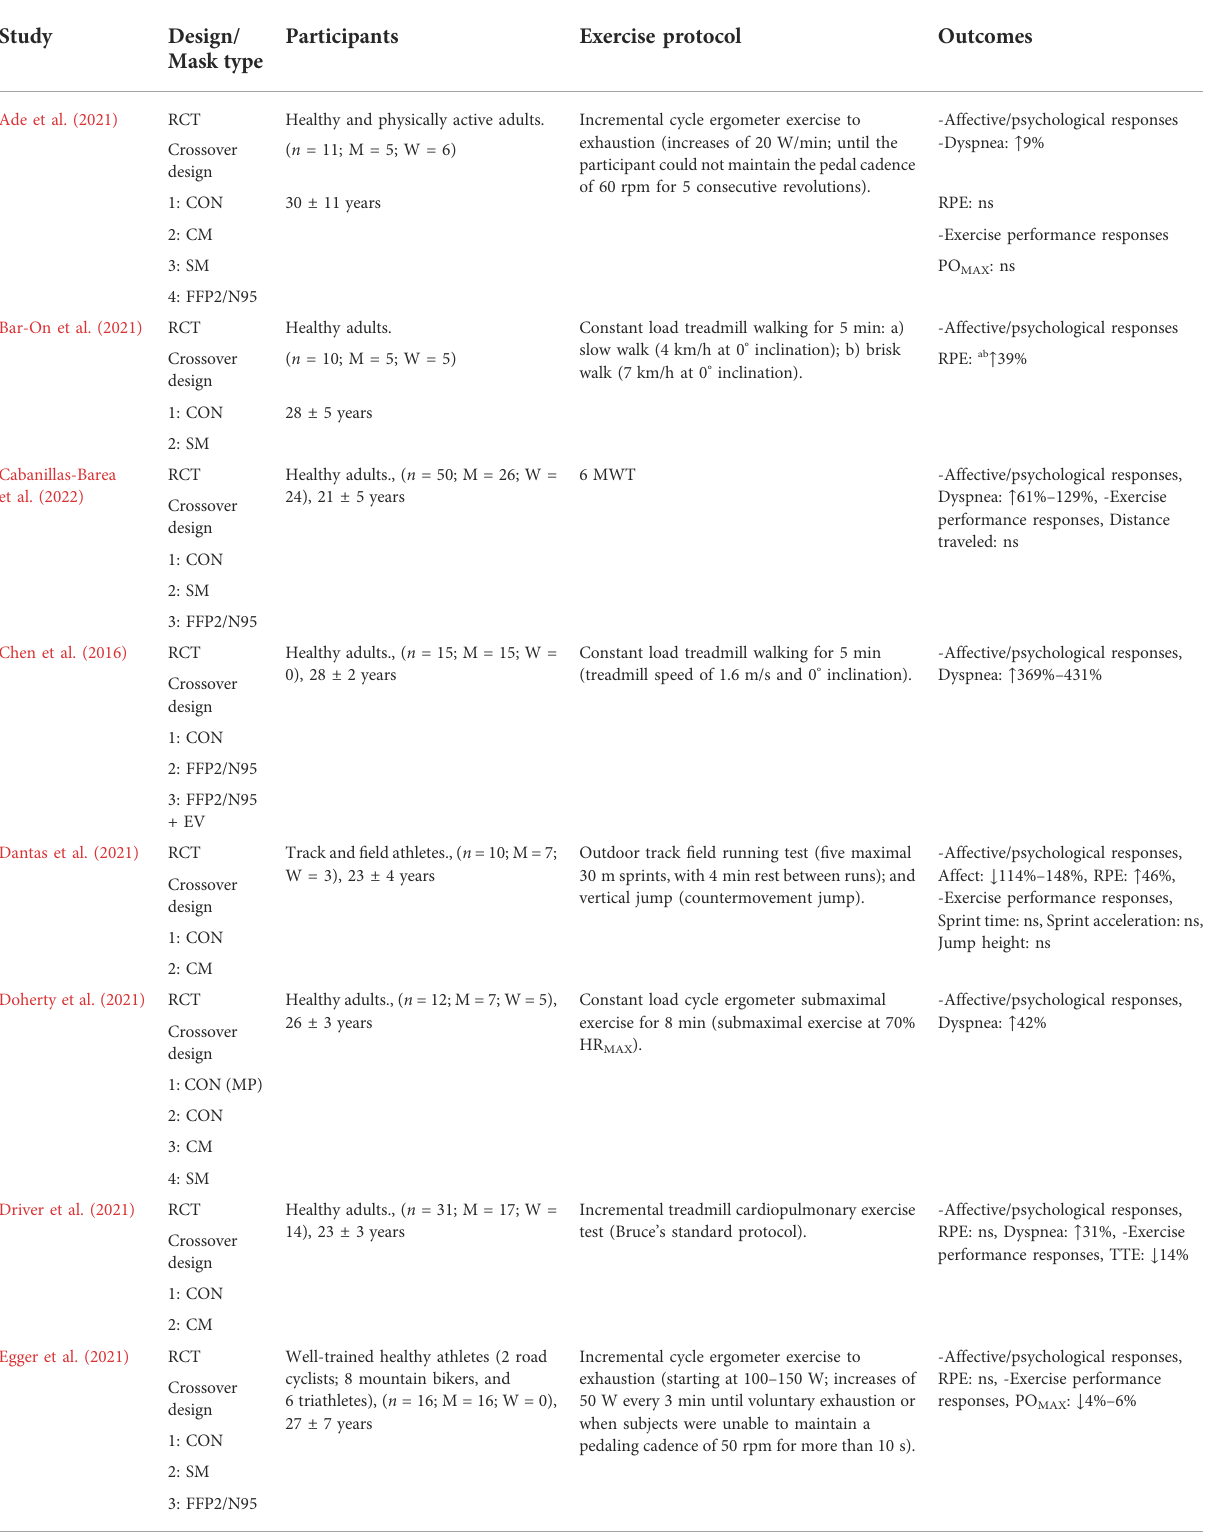
TABLE 1 Summary of studies on the acute effects of comparison between use of mask versus no-mask wearing during exercise.